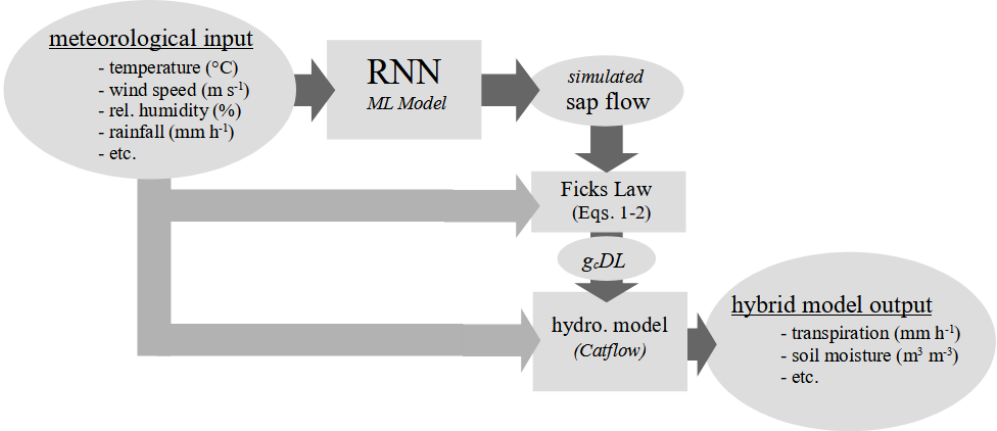
Figure 2. Flow chart of the hybrid model that combines a recurrent neural network (RNN) and a process-based hydrological model to estimate